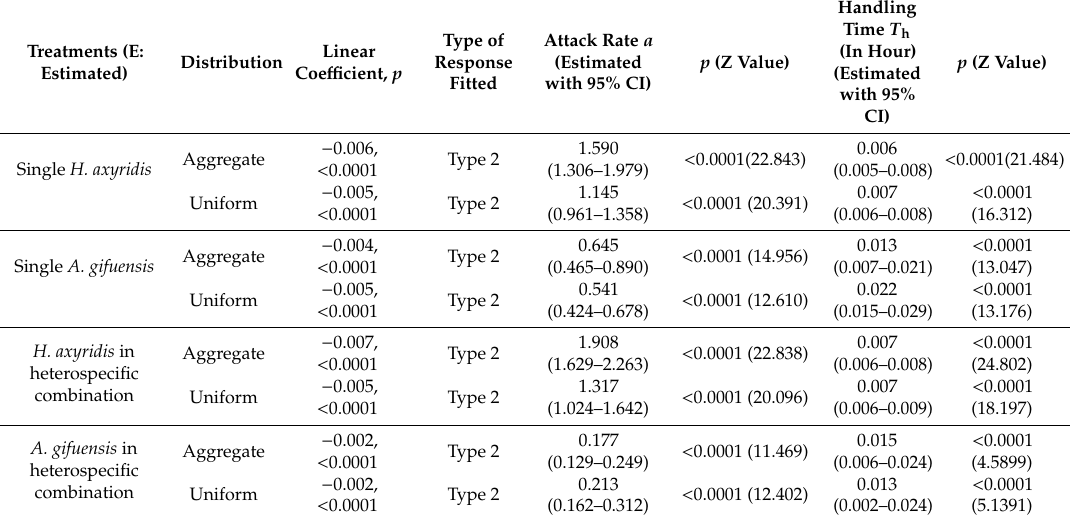
Table 1. Significance levels from linear-term logistic regression of the number of Myzus persicae killed by single Harmonia axyridis or Aphidius gifuensis , individual H. axyridis or A. gifuensis in heterospecific combination at 24 h in two aphid distributions, and functional response parameters for Rogers random predator equation ( a and T h with mean, 95% CI).